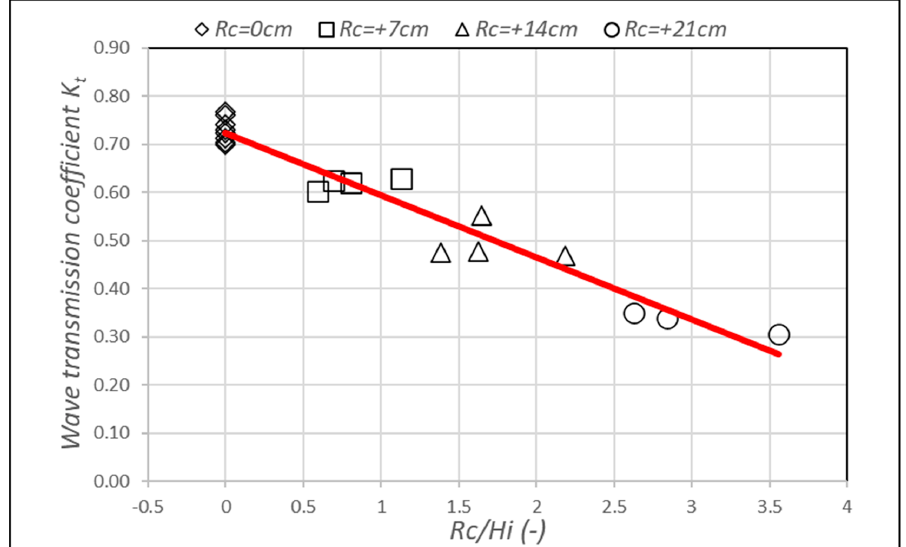
Figure 12. Influence of the crest freeboard on the wave transmission coefficient K t . Figure 13 provides a comparison of wave transmission coefficients versus relative crest freeboards of different types of breakwaters. A comparison of the K t values between the HTB, PRWB, and rubble-mound breakwaters reveals that the transmission efficiency is low when the breakwaters are working in the emerging state. However, when break- waters are submerged, the transmission coefficient of the rubble mound has the lowest value, with K t < 0.2. Rubble-mound breakwaters almost completely prevent incoming waves. Porous breakwaters, like HTBs and PRBWs, still enable waves to pass through the layer to a certain degree, and the transmission coefficients are almost unchanged, K t = 0.3– 0.4. The PTPBW results presented in this figure correspond to the selected pore diameter (TH6, front-side porosity is 17.6%, D = 5.7 cm, and the back-side porosity is 12%, D = 4.1 cm). We note that although we favour the penetration of sediment-laden waters, the pro- posed PTPBW structure gives values of wave transmission coefficients that are compara- ble with the other structures. When R c / H mo,i > 2, the wave transmission coefficients given by the PTPBWs are nearly identical to those of the HTBs and PRBWs. This ensures that the main purpose of the PTPBWs is to facilitate sediment transport along the structure and stimulate sedimentation behind it.